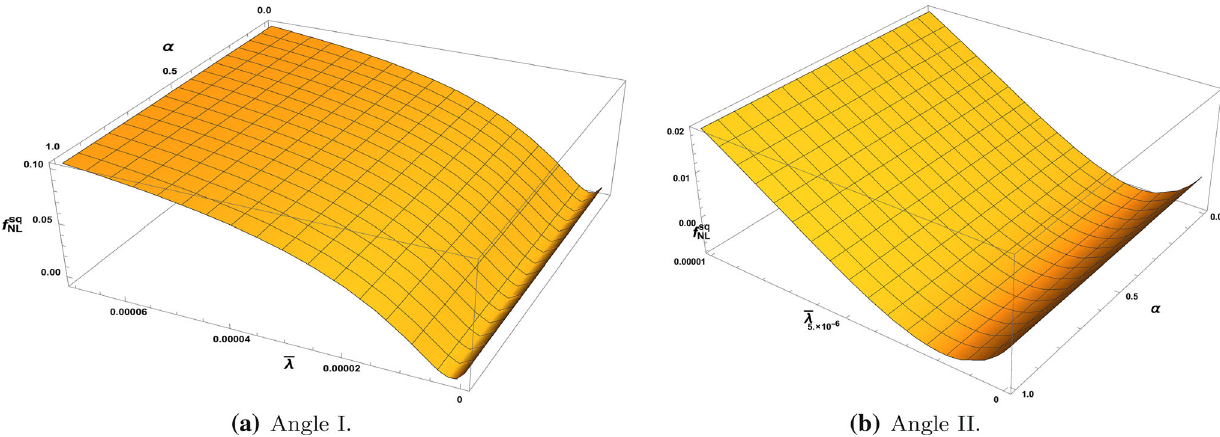
Fig. 15 Representative 3D diagram for squeezed non-Gaussian three point amplitude vs. the model parameters α and ¯ λ for N cmb = 60 in two different angular